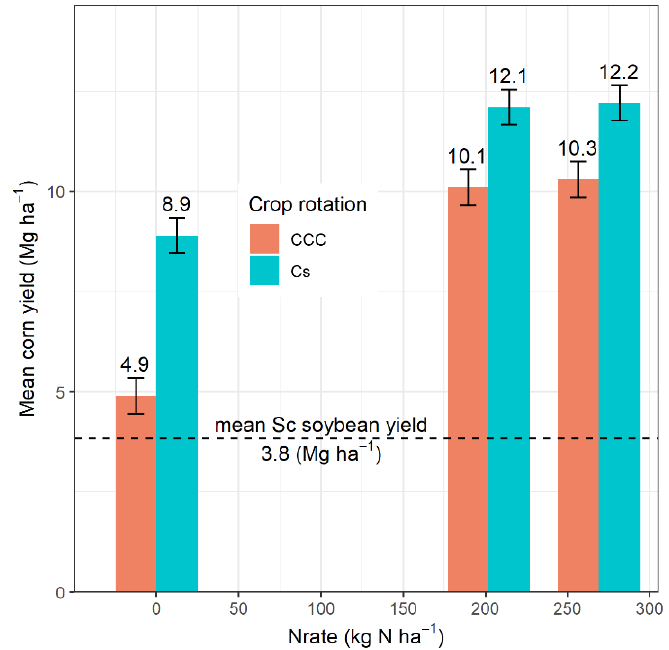
Figure 7. Average corn yield (Mg ha − 1 ) during the 36 years of the study for each cropping system and for each level of N fertilization. Average soybean yield (Mg ha − 1 ) is included as reference (dashed line). Error bars represent the standard error of the treatment means. Crop rotations are continuous corn (CCC), and the corn-soybean rotation (CS) as corn Cs and soybean (Sc) phase, respectively. The N fertilization rates were 0, 202, and 269 (kg N ha − 1 ).